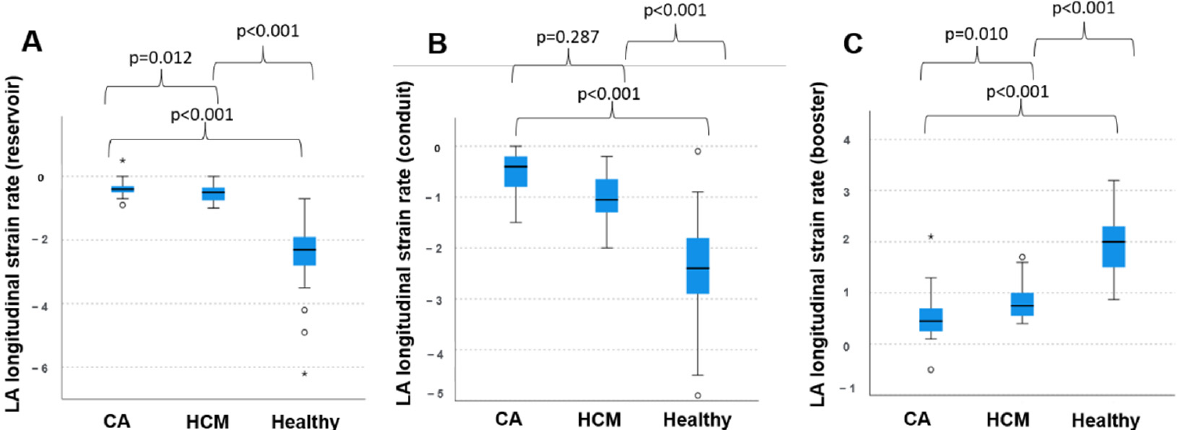
Figure 3. Left atrial strain rate in patients with cardiac amyloidosis and hypertrophic cardiomy- opathy and healthy subjects. ( A ) Longitudinal left atrial reservoir strain rate, ( B ) longitudinal left atrial conduit strain rate and ( C ) longitudinal left atrial booster strain rate within the three groups, respectively. CA: cardiac amyloidosis; HCM: hypertrophic cardiomyopathy; LA: left atrial. *: extreme values, ○: outliers.